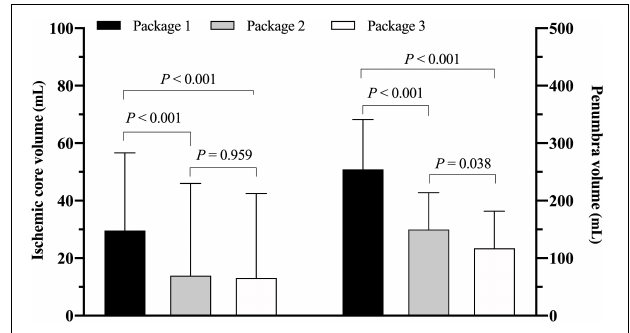
FIGURE 1 | Comparison of ischemic core volume in panel (A) and penumbra volume in panel (B) among three software packages [Package 1: IntelliSpace portal (ISP); Package 2: Rapid processing of perfusion and diffusion (RAPID); Package 3: Fast-processing of ischemic stroke